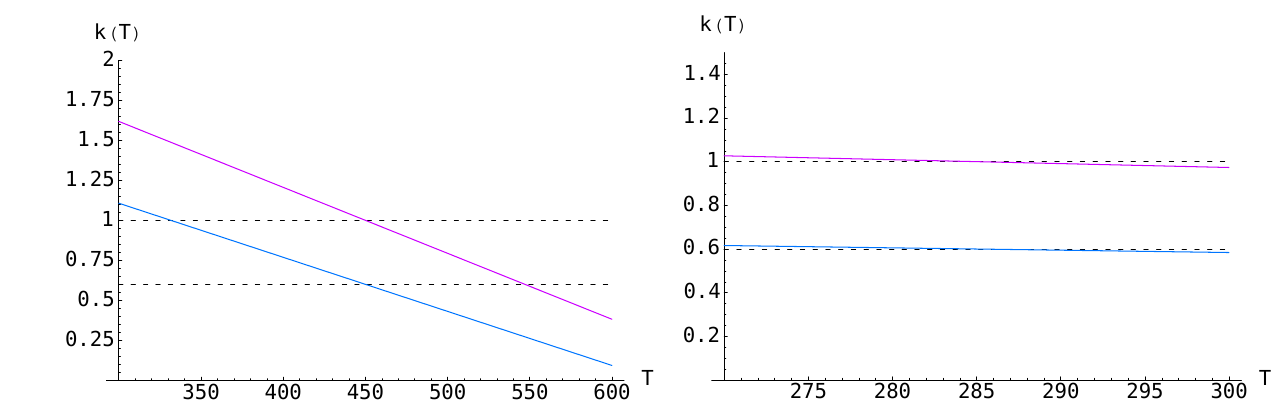
= 1 . 055 for k opt